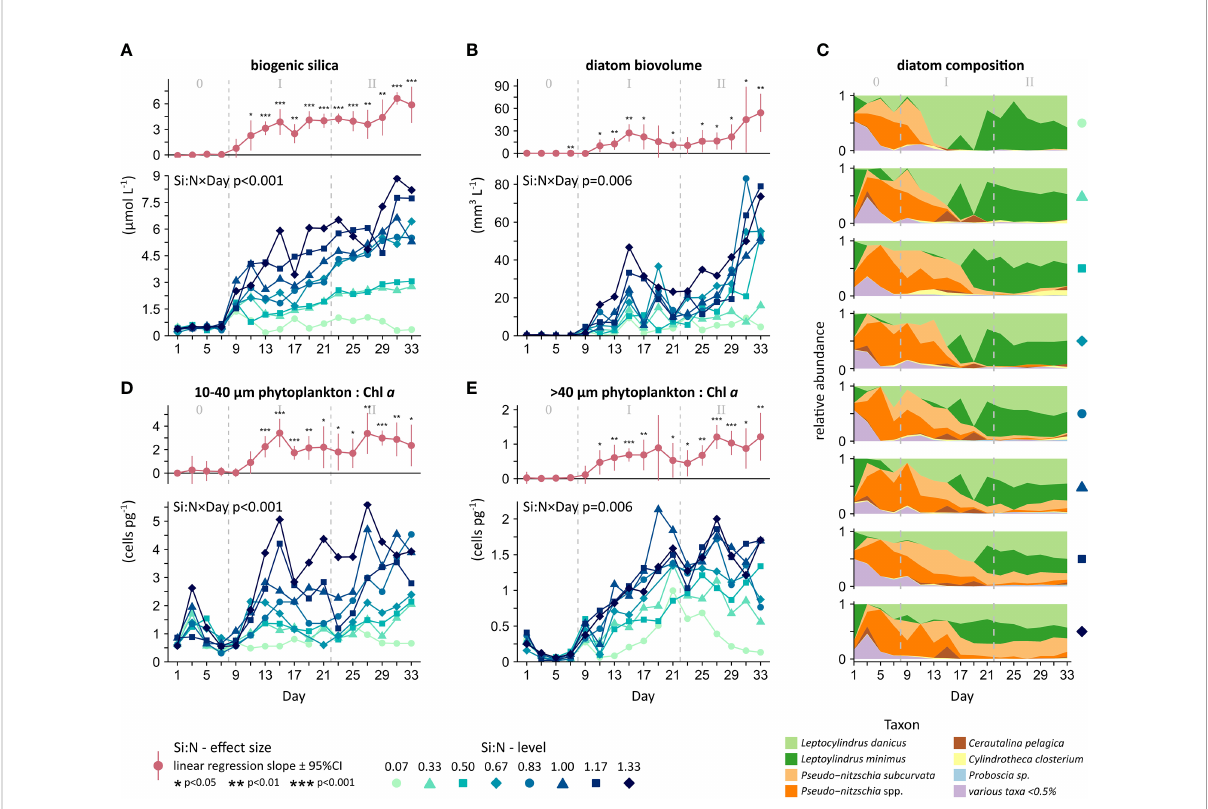
FIGURE 5 Larger phytoplankton under upwelling with varying deep water Si:N, including (A) biomineralized Si, (B, C) diatoms only (via microscopy), and (D, E) the abundance of all larger phytoplankton (via fl ow cytometry) relative to the chlorophyll a of the entire autotrophic community. Provided are the overall signi fi cances across time (Si:N, Day or Si:N×Day) and the daily Si:N effect (in red). Experimental phases: 0 = oligotrophic baseline, I = initial response, II = longer-term